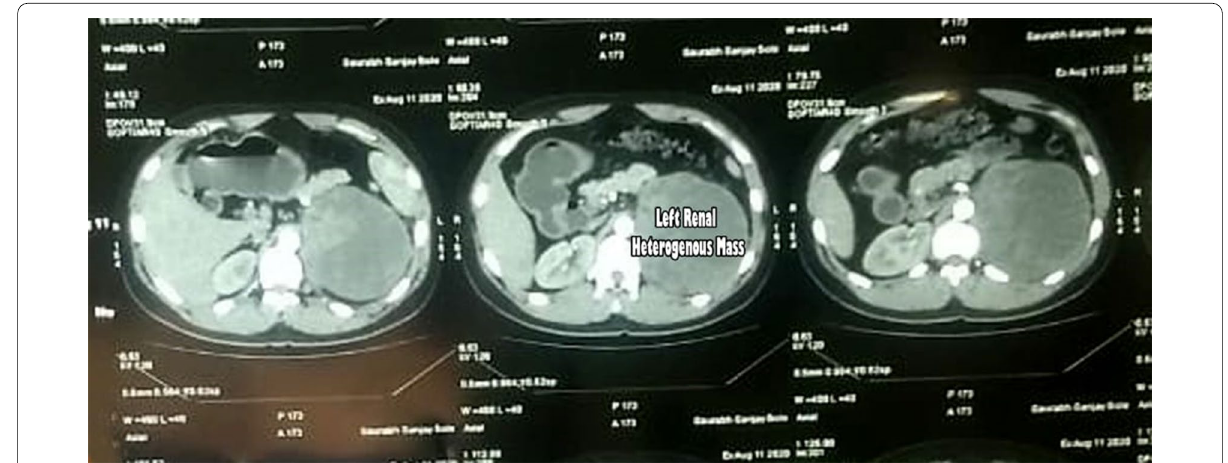
Fig. 1 CT scan of left renal PNET tumour